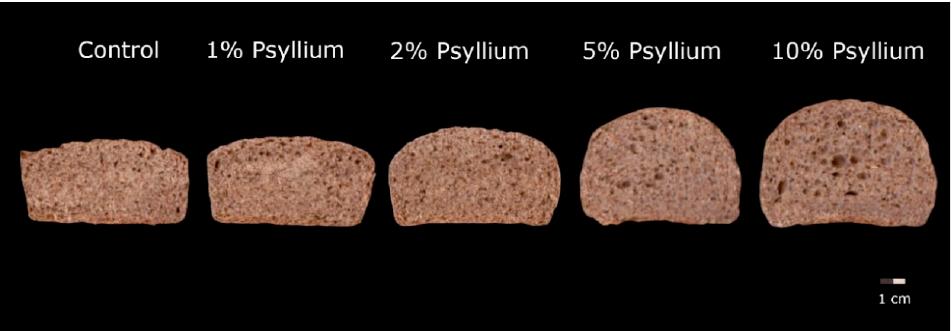
Figure 2. Image of the central slices of control and psyllium added whole breads. Control: whole wheat flour; psyllium 1%: whole wheat flour with 1% psyllium; psyllium 2%: whole wheat flour with 2% psyllium; psyllium 5%: whole wheat flour with 5% psyllium; psyllium 10%: whole wheat flour with 10% psyllium.